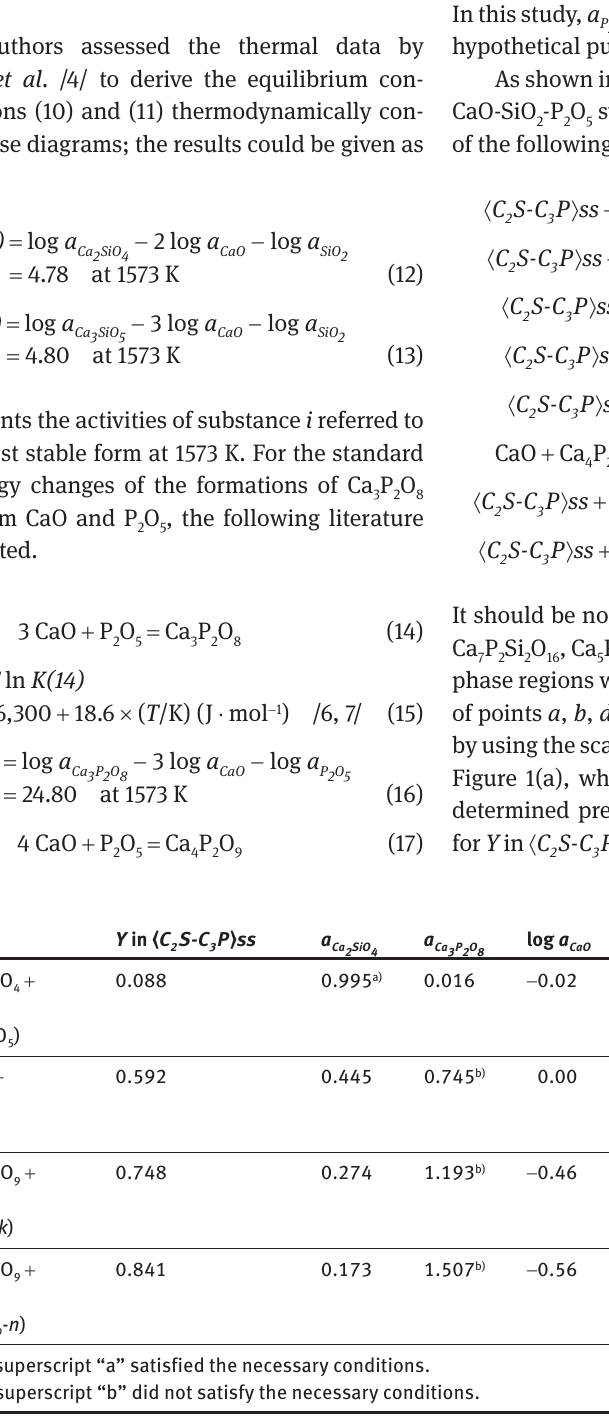
Table 1: Calculation results of the ideal solution model with D H ° t (Ca 3 P 2 O 8 ) = 101 kJ ⋅ mol − 1